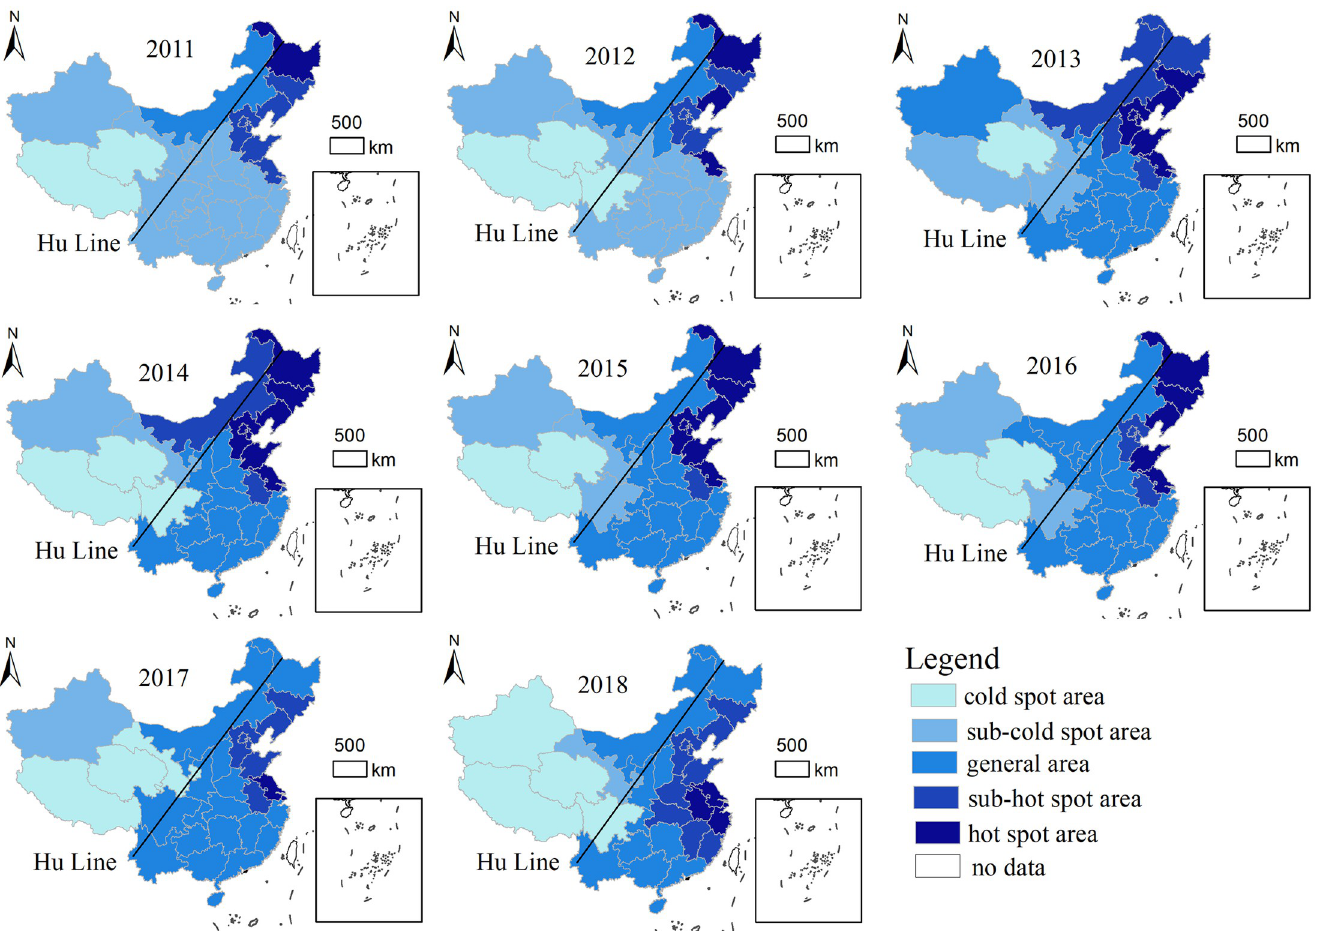
Fig 3. Distribution map of travel demands to North Korea (The administrative boundaries were obtained from the Chinese National Geographic Information Center (http://ngcc.sbsm.gov.cn), using Acrgis 10.6.1 for visual processing. The figure is similar but not identical to the original image and for illustrative purposes